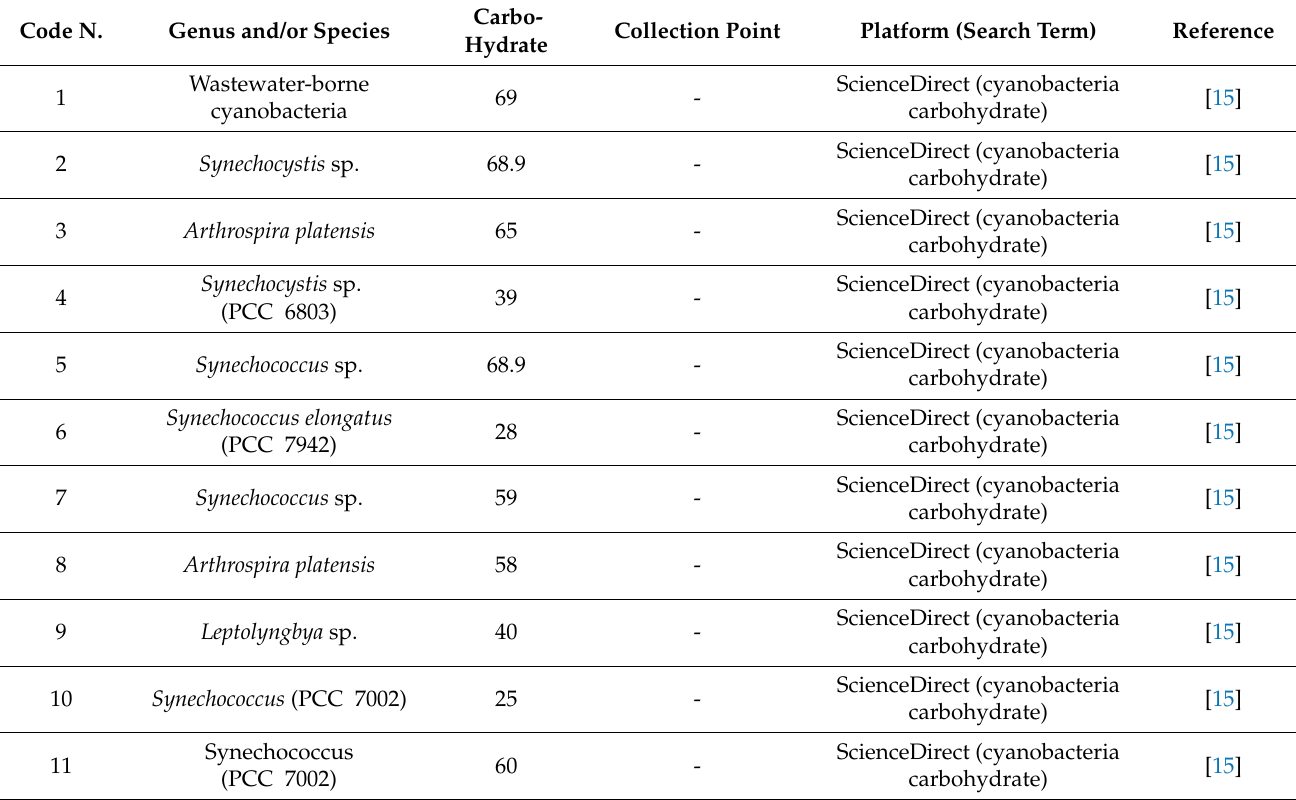
Table 6. Carbohydrate content in cyanobacteria selected for this review [15,41,49,64,68–75] 1 . Code